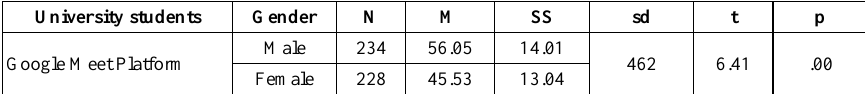
Table 5. Distance education attitudes of university students by gender